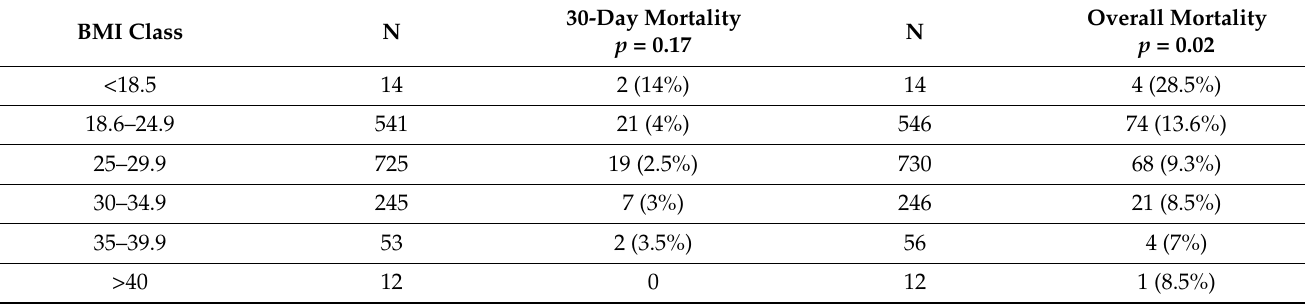
Table 3. Mortality according to BMI class.